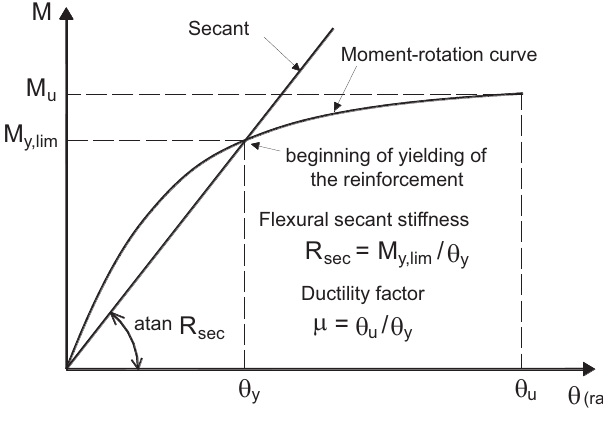
Figure 1 Moment-rotation curve of a beam-column connection: NBR 9062 [27]